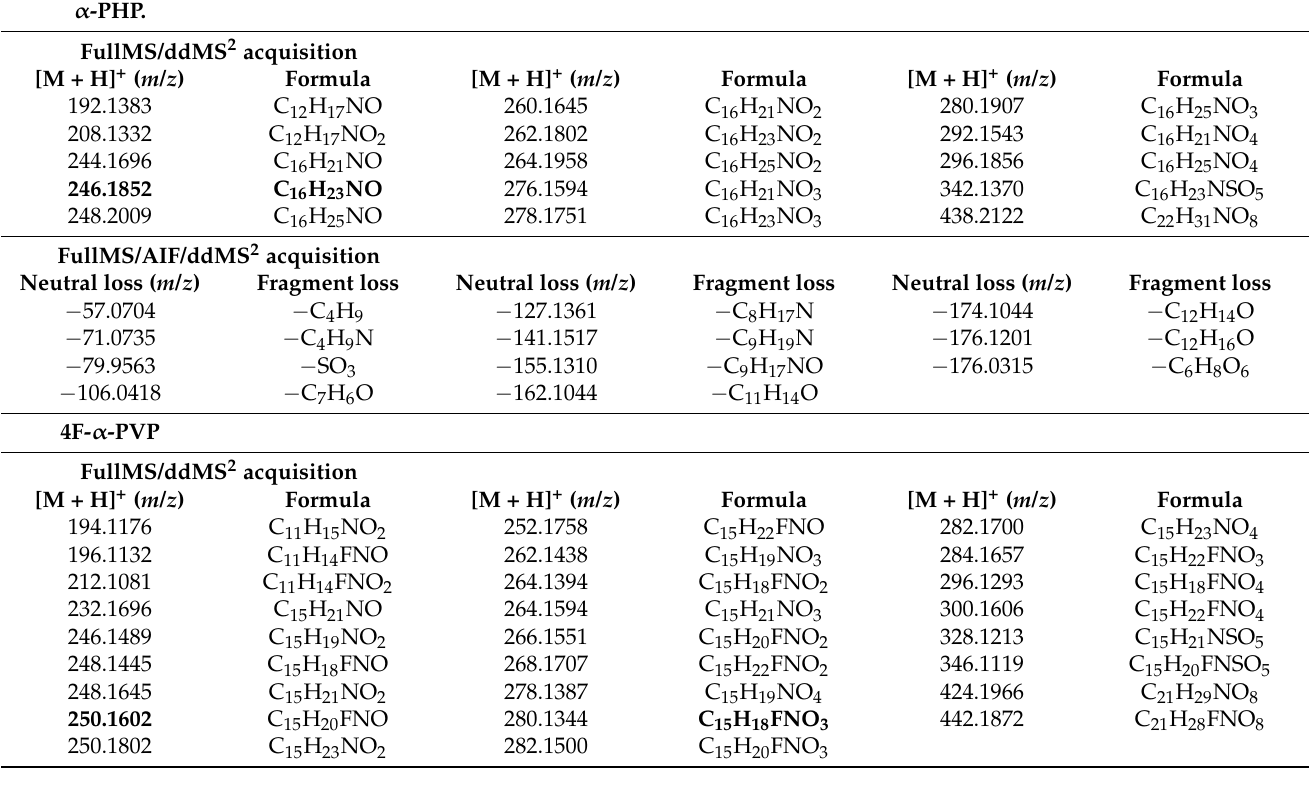
Table 2. Inclusion and neutral loss lists for the FullMS/ddMS2 and FullMS/AIF/ddMS2 acquisitions, respectively, used during HRMS analysis of hepatocytes incubations. FullMS/ddMS2, full-scan mass spectrometry/data-dependent tandem mass spectrometry; FullMS/AIF/ddMS2, full-scan mass spectrometry/all-ion fragmentation/data-dependent tandem mass spectrometry; HRMS, high resolution mass spectrometry. α